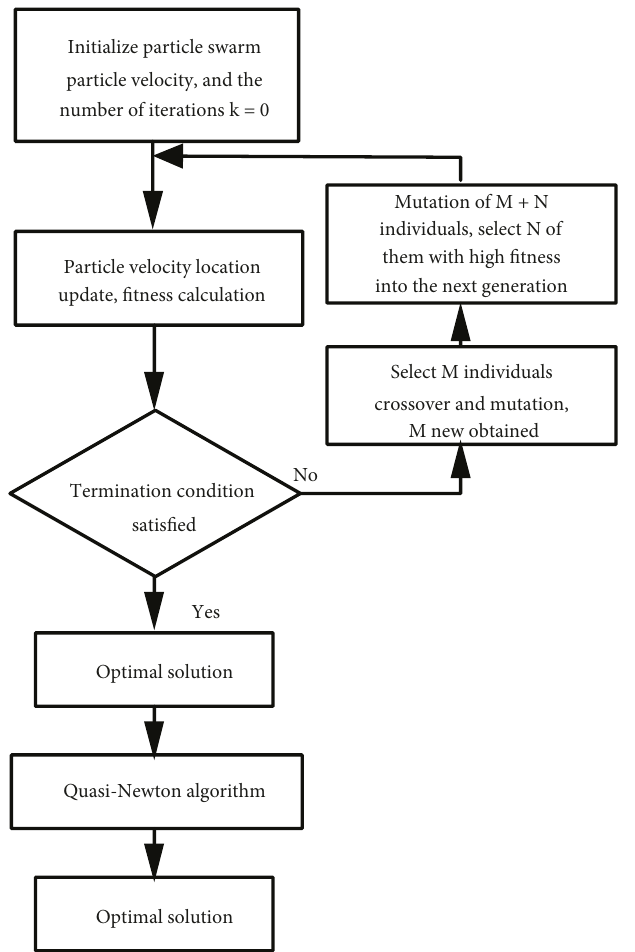
Figure 8: Proposed GPSO-QN algorithm